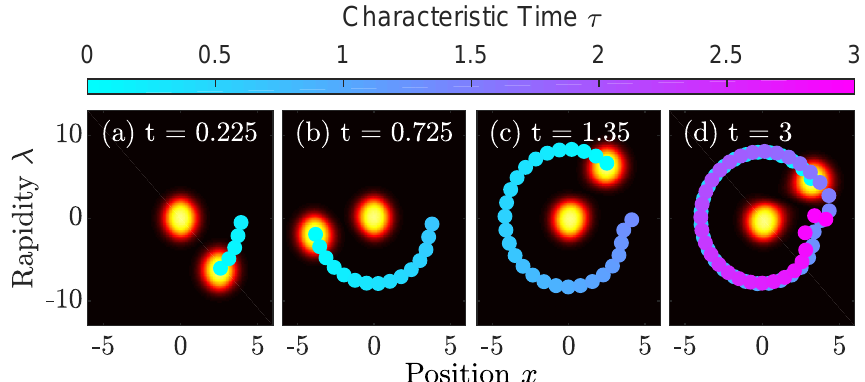
Figure 3: Interpretation of characteristics as inverse quasiparticle trajectories. The plots show the filling function at various times, ϑ ( t ) , overlaid with the characteristic coordinates ( U ( τ ) , W ( τ )) . The coordinates mark the location of the quasiparticle at time t − τ , which later at time t is found in the center of the encircling filling. The clouds interact whenever they overlap in space causing a distortion of the quasipar- ticle trajectories. For detailed description refer to main